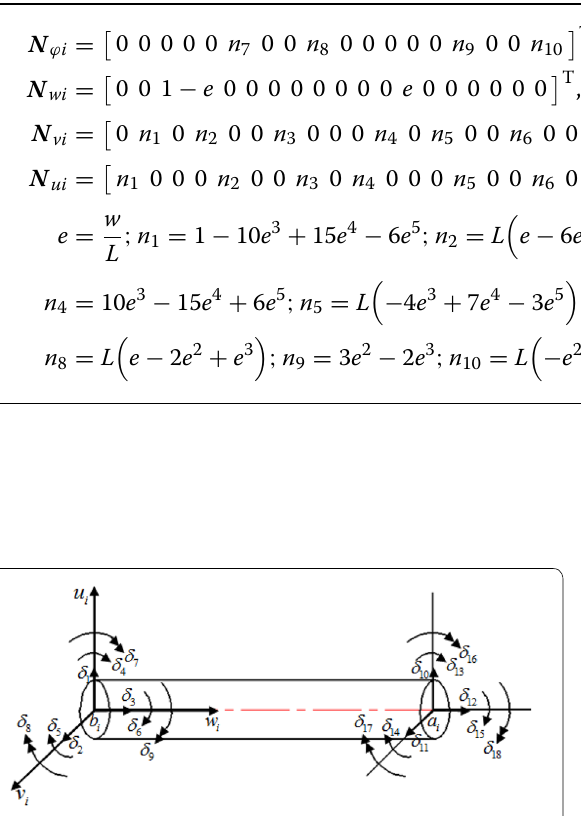
Figure 3 Schematic of spatial flexible beam